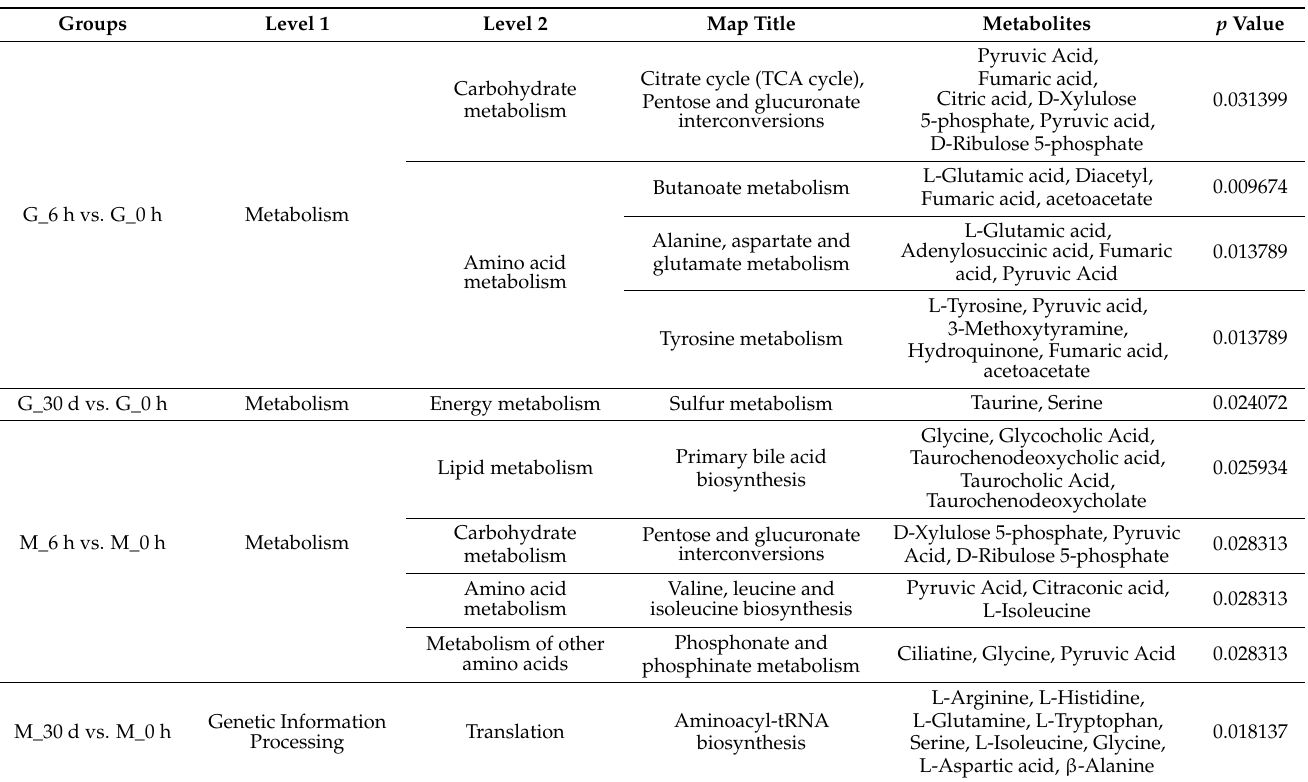
Table 1. KEGG pathway enrichment results of significantly different metabolites (SDMs) of C. farreri under heat stress for 6 h and 30